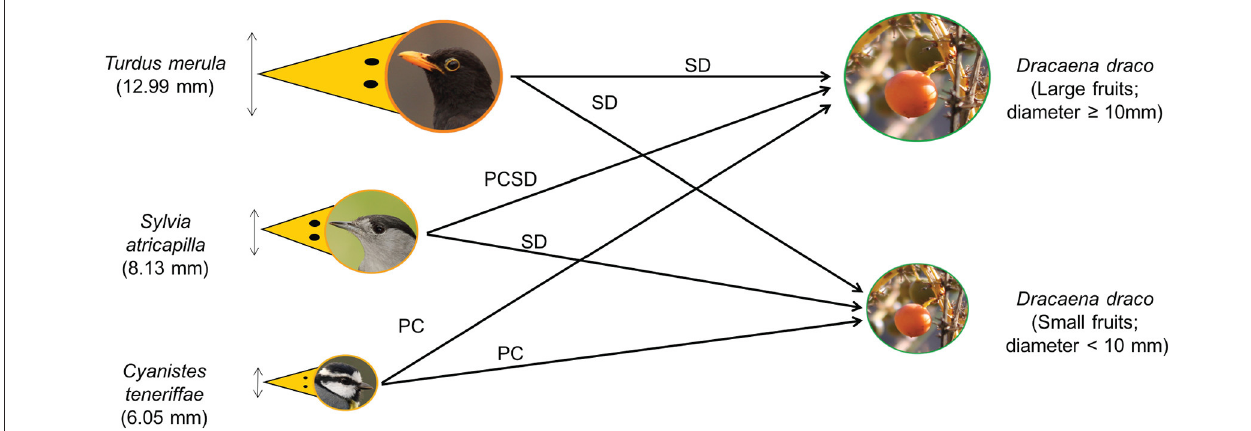
FIGURE 1 | Conceptual framework of our hypothesis. Medium size passerines, such as Turdus merula , can swallow Dracaena draco fruits whole and act as legitimate seed dispersers (SD), regardless of fruit width. Small passerines were expected to act mostly as pulp consumers (PC). Large small passerines (e.g., Sylvia atricapilla ) may be able to swallow whole small-width fruits and legitimately disperse the seeds (SD), whereas they will only peck out the pulp of large fruits, acting as pulp consumers (PC). Nonetheless, small passerines may occasionally be able to transport large fruits to consume the pulp away from parent trees, leading to seed dispersal without digestive treatment (PCSD). For each bird, its mean beak gape width is shown between parentheses (AG-C, unpubl. data). The terms used to define the type of fruit-handling behavior follow Wheelwright (1985) and Jordano and Schupp (2000). Picture credits: birds by Beneharo Rodríguez and D. draco fruit by